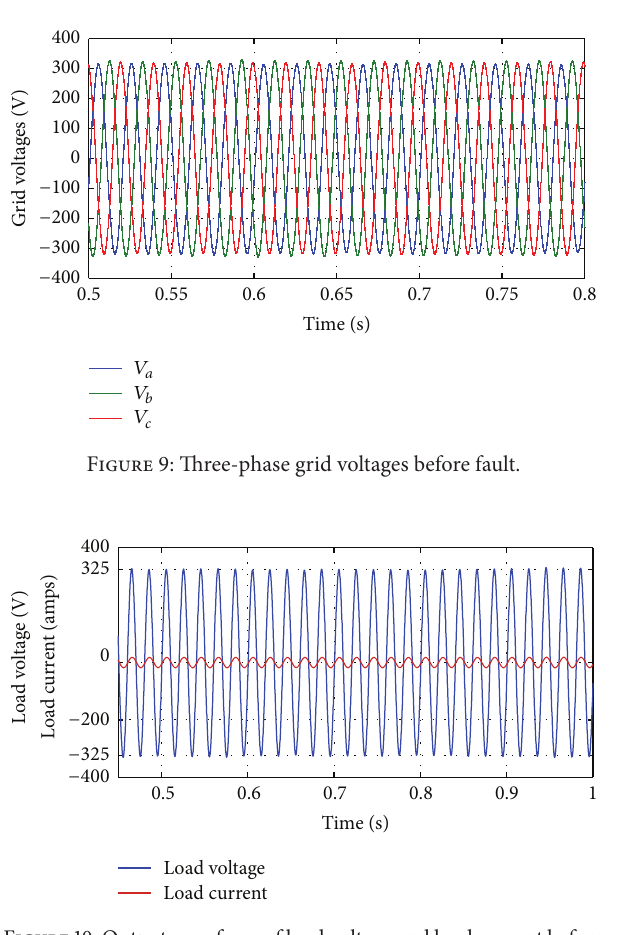
Figure 12: Source current, local load current, and shared load cur-